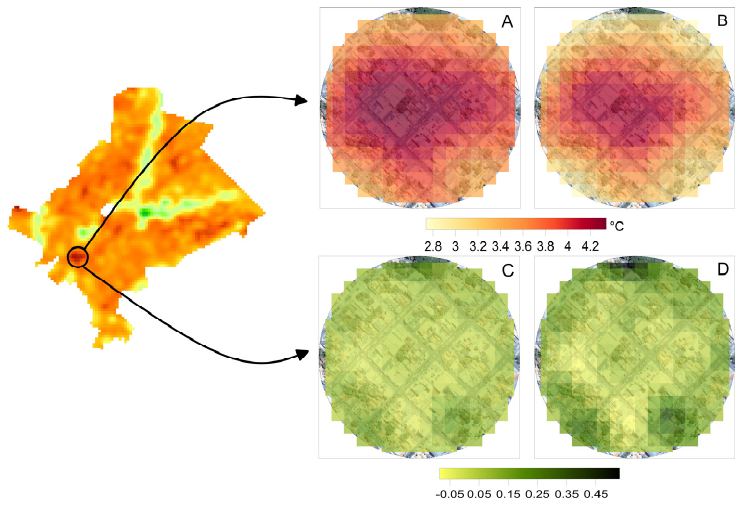
Figure 11. ( A )—Effective UHI; ( B )—Simulated UHI; ( C )—Observed NDVI; ( D )—Simulated NDVI.